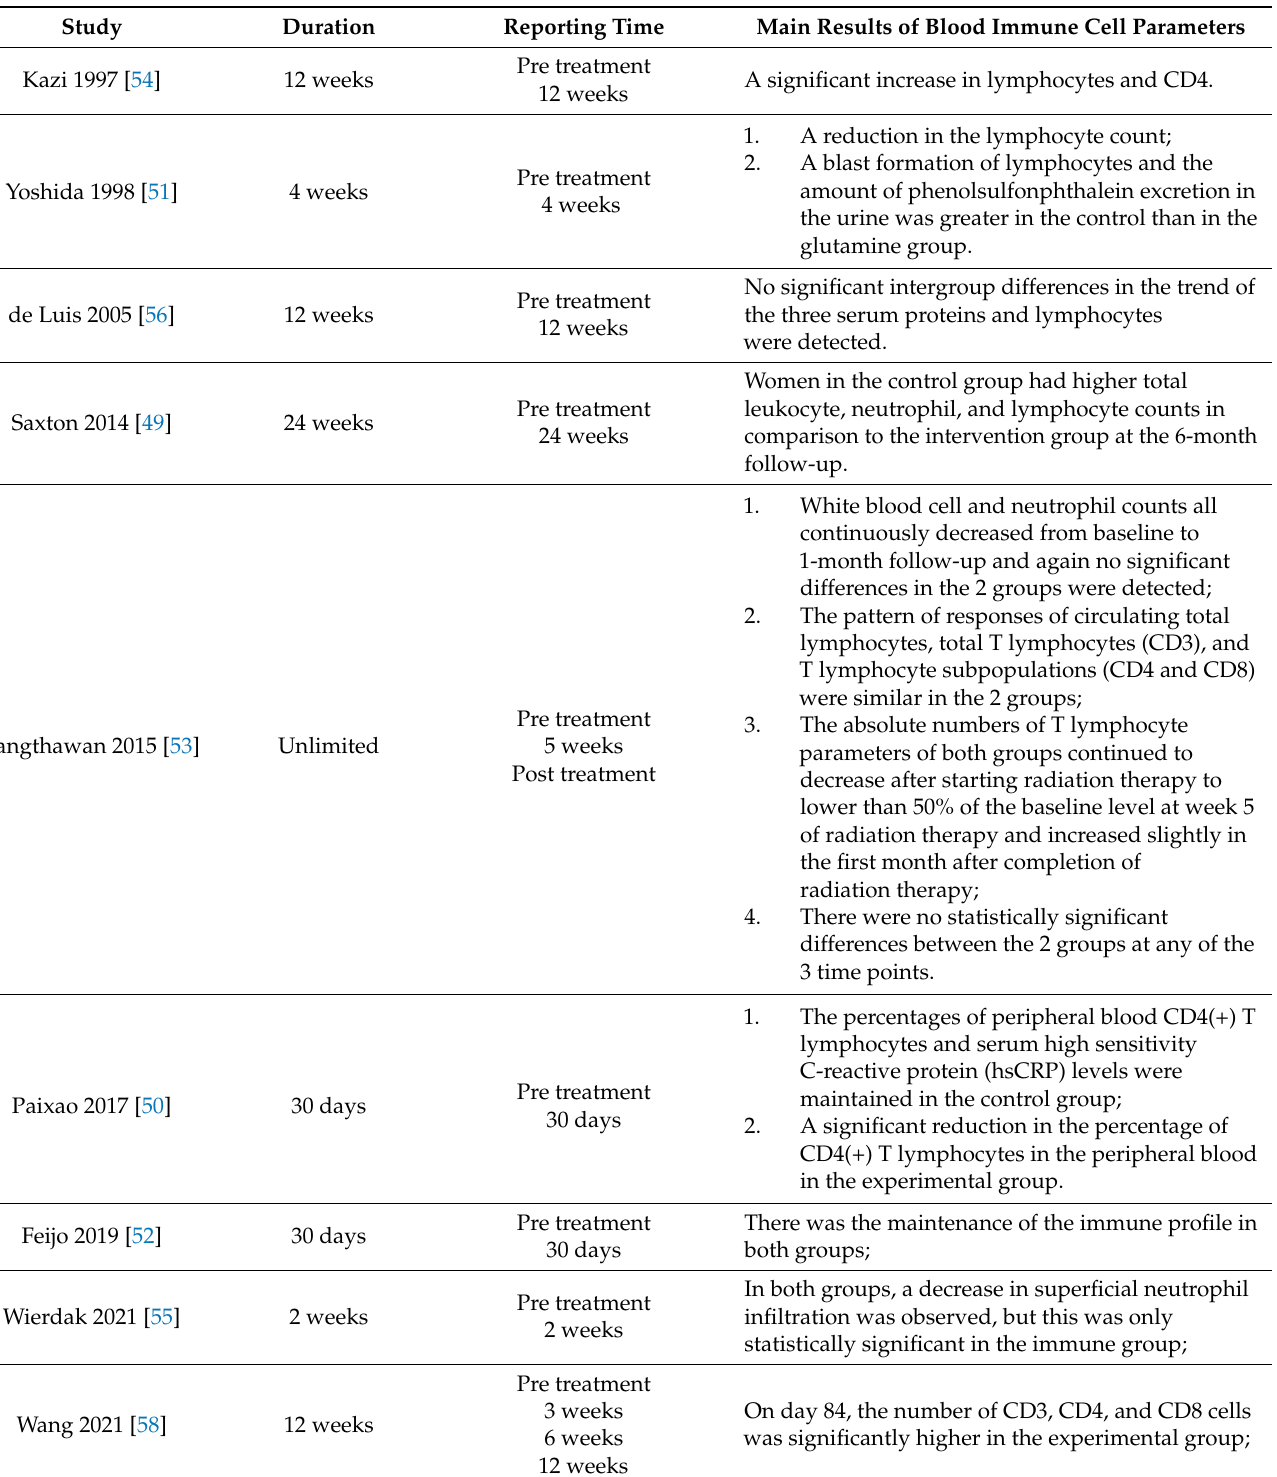
Table 2. Results of Individual